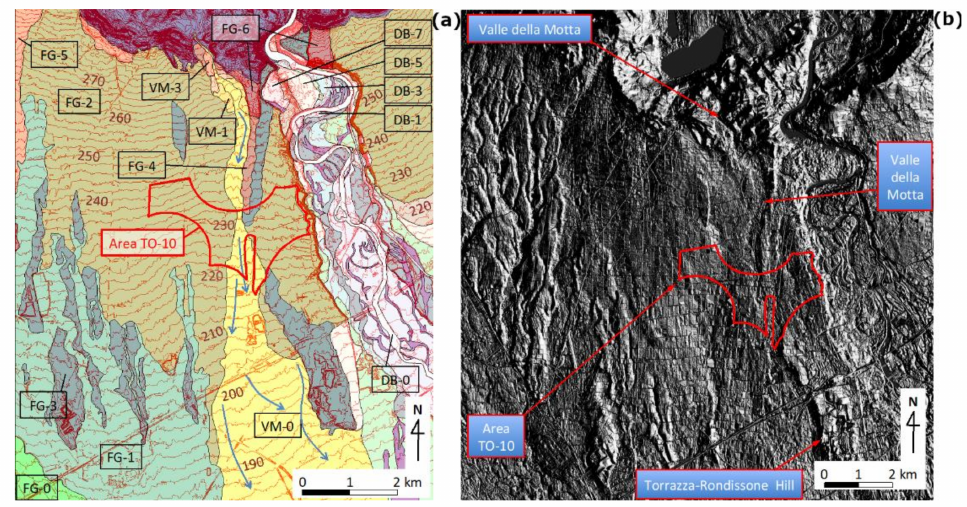
Figure 6. ( a ) Map of local terraces. Recent terraces within the Dora Baltea River cañon are indicated with DB-1 (youngest) to DB-7 (oldest). DB-0 is the active riverbed. Older fluvio-glacial plane terraces are indicated with FG-1 (youngest) to FG-6 (oldest). FG-0 is the Po River sediments layer. The “Valle della Motta” terraces are labelled with VM-1 to VM-4, while the VM-0 is the active drainage. Note that there are no secondary streams developing along the side of the Dora Baltea River cañon. The “Valle della Motta” is the long drainage that begins in the Ivrea moraines (as abandoned glacial outwash river) in the North and extends all the way to the bottom of the figure. ( b ) Shaded relief from the regional 5 × 5 m grid sized DTM of the TO-10 area. A set of terraces can be recognized in the glacio-fluvial sediments. The Dora Baltea cañon cuts these sediments in a NW-SE direction on the right side of the